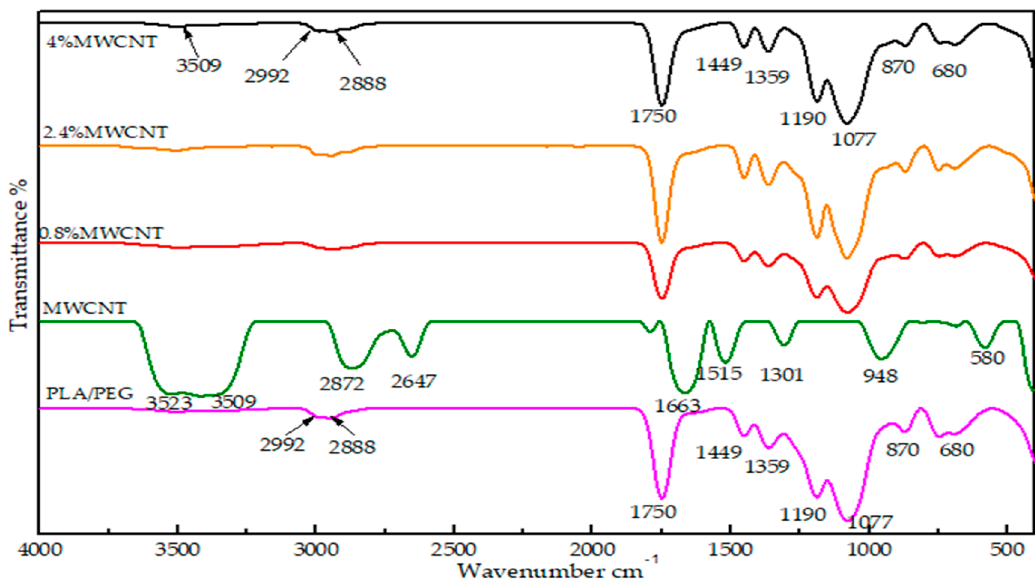
Figure 6. Fourier Transform Infrared (FT-IR) spectra of PLA / PEG blend, MWCNTs powder, and MWCNT / PLA / PEG nanocomposites with di ff erent MWCNTs loading (0.8 wt.%, 2.4 wt.%, and 4 wt.%).